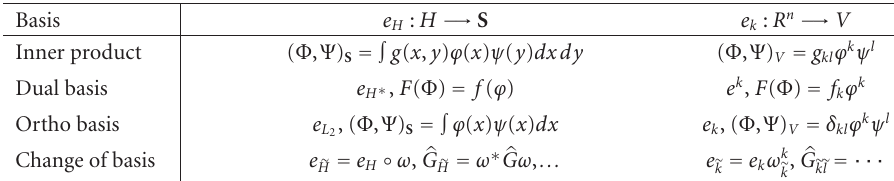
Table 4.1. Classical versus string